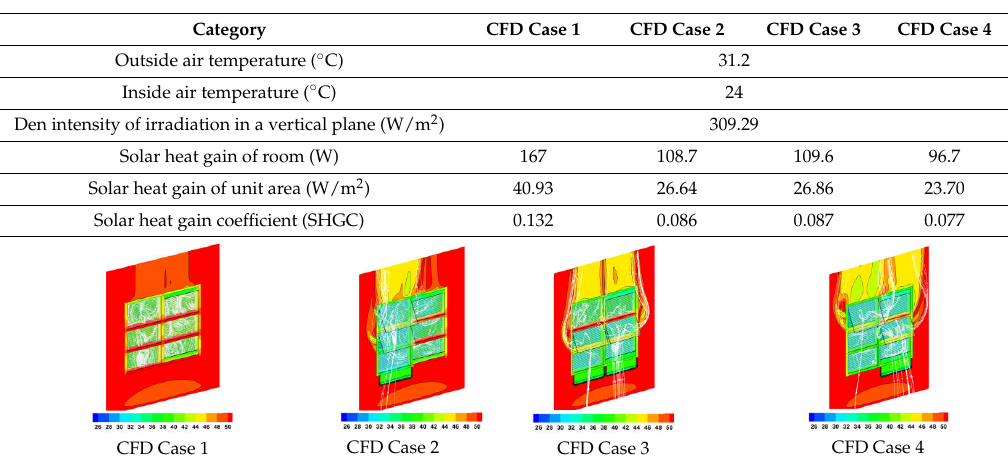
Table 14. CFD conditions and results.